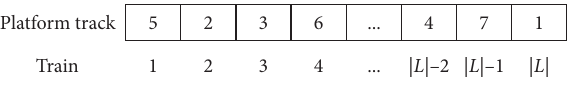
Figure 5: Illustration of the chromosome